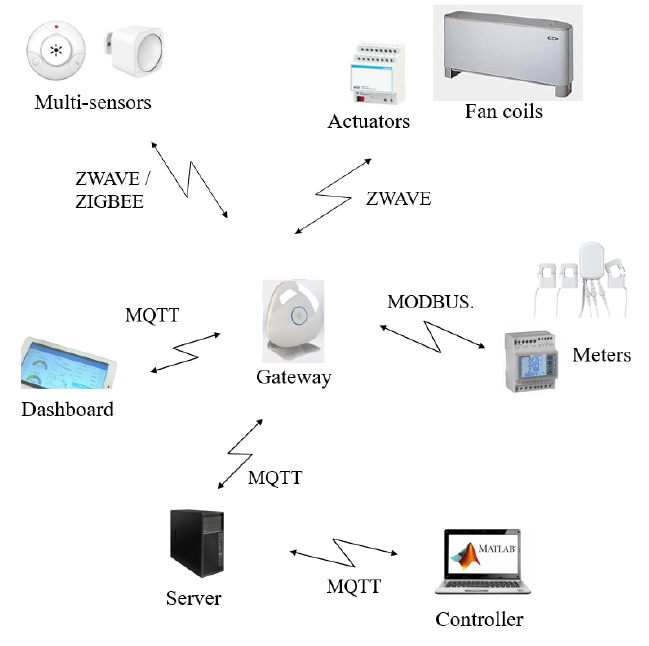
Figure 4. Architecture of the deployed experimental